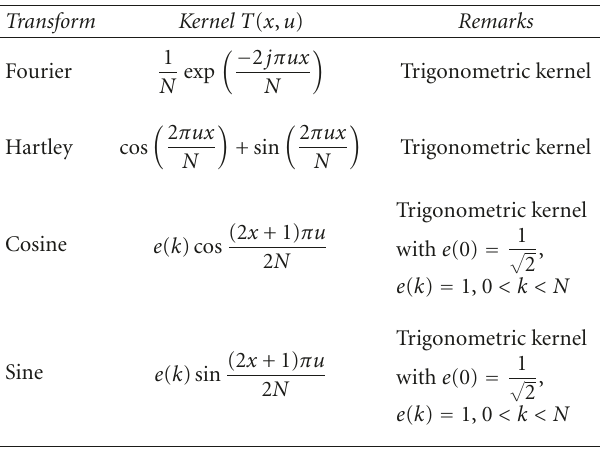
Table 1: Some integral